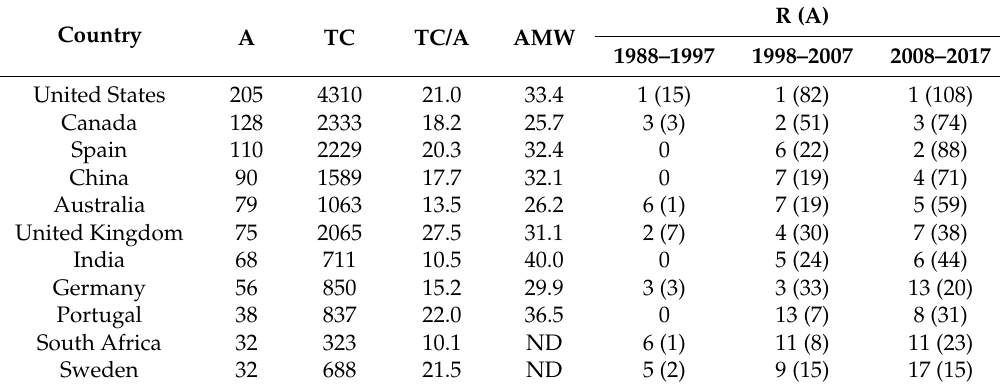
Table 10. Most productive countries in MMW